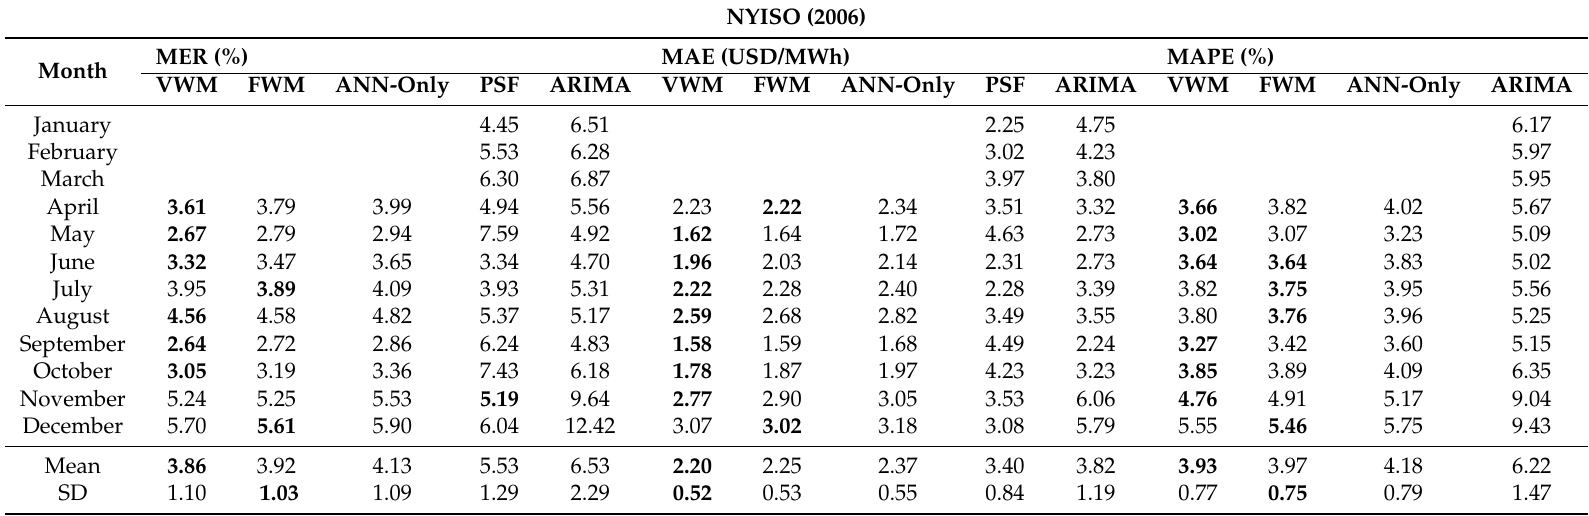
Table 2. MER (Mean Error Relative to the mean actual price), MAE and MAPE evaluation metrics for the NYISO market for the year 2006 (Experiment I-A). VWM, Varying Weight Method; FWM, Fixed Weight Method; PSF, Pattern Sequence-based